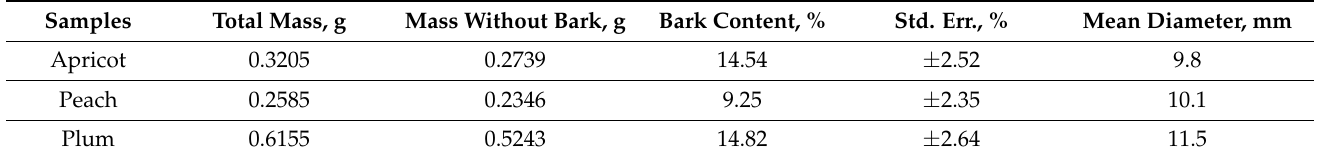
Table 2. Bark content of